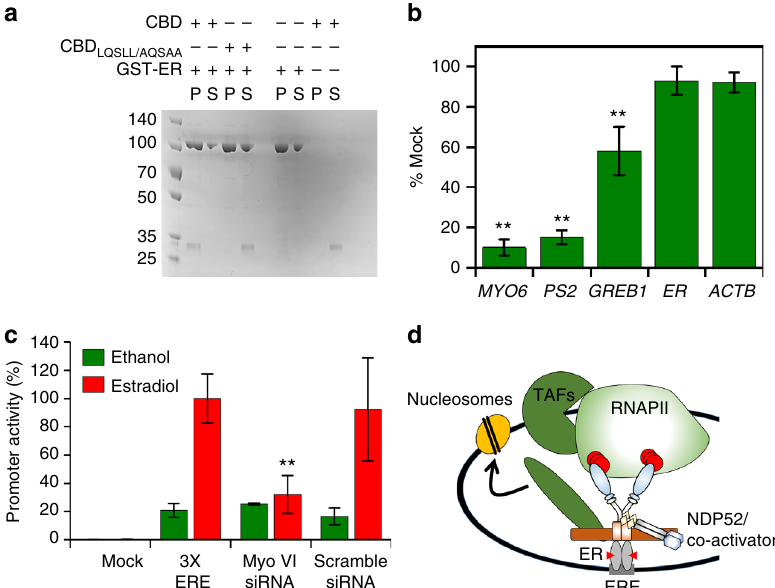
Fig. 8 Myosin VI is linked to oestrogen signalling. a Pull-down of 2 μ M CBD by 10 μ M GST-ER. P and S represent pellet and supernatant fractions. b Expression of ER gene targets following siRNA knockdown of MVI in MCF-7 cells. Expression is plotted as a percentage of expression in mock cells. ER ( ESR1 ) and β -actin were used to re fl ect global changes in transcription. c Luciferase reporter assay driven by the ERE promoter in MCF-7 cells. Estradiol led to a 5-fold increase in promoter activity. siRNA knockdown of MVI led to a 3-fold reduction in activity. Ethanol was used as a carrier control for the experiments (error bars represent SEM from three independent experiments ** p < 0.001 by two-tailed t -test). d Working model of MVI recruitment by the ER. MVI binds to the ER and then gets activated by NDP52 (or CoCoA), which enables binding to RNAPII through actin. Association with NDP52, or CoCoA, ties MVI with the general transcription co-activators to initiate recruitment of